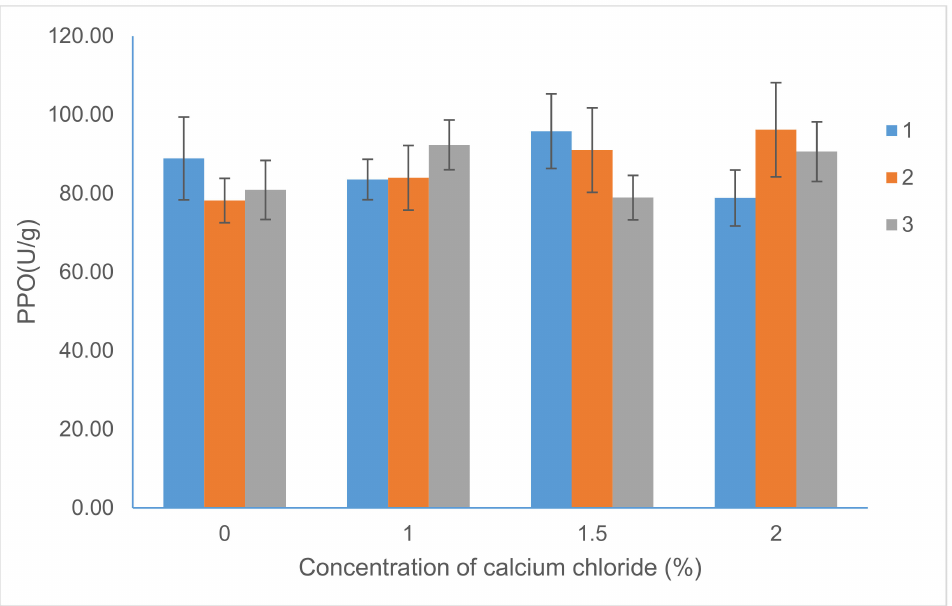
Figure 11. The interaction effects of harvesting stages (1 = green mature, 2 = breaker and 3 = half-ripe) and CaCl 2 (0, 1, 1.5, and 2%, w / v ) on PPO enzyme unit activity of MT-3 tomato fruit stored at ambient temperature (28 ± 2 ◦ C and 75 ± 5% RH). Vertical bars indicate the standard error of means for 4